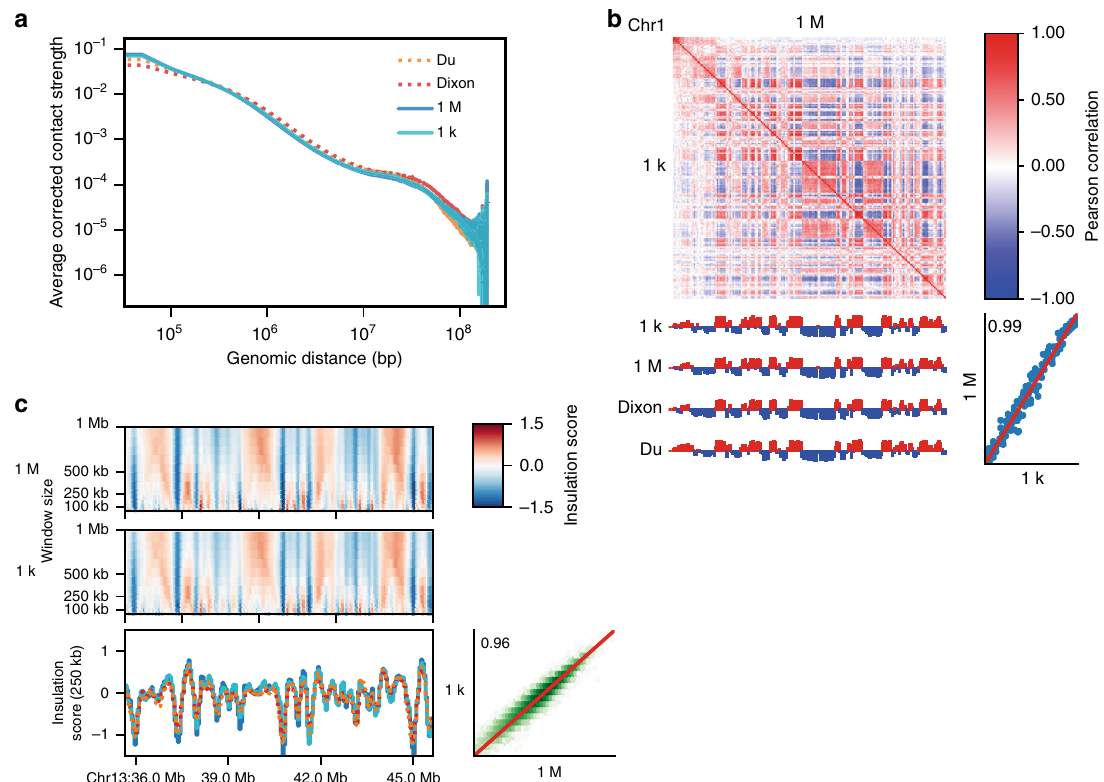
Fig. 3 Compartments, TADs and loops can be detected and are highly reproducible in Low-C data. a Log – log ‘ distance decay ’ plot for chromosome 1 showing the decrease in contact probability between 50 kb bins with increasing distance for the 1 M and 1 k, as well as the Dixon et al. 15 and Du et al. 12 samples. b AB compartment comparison for chromosome 1 binned at 1 Mb. Contact correlation matrices for the 1 M and 1 k samples (top) and the corresponding fi rst eigenvector (coloured according to the sign of the eigenvector entries) for the samples listed in a are shown on the left. Bottom right shows a scatter plot of fi rst eigenvector values of the 1 M vs. the 1 k sample with Pearson correlation coef fi cient shown in the plot. Red line indicates identity. c Insulation score 20 comparison for the region on chromosome 13 shown in Fig. 1b. Heatmaps display insulation score values for a range of window sizes, line plots highlight the insulation index for a window size of 250 kb (see panel a for line colours). Next to it is a scatter plot with the Pearson correlation coef fi cient of the complete insulation index vectors for the 1 k and 1 M samples. Red line indicates